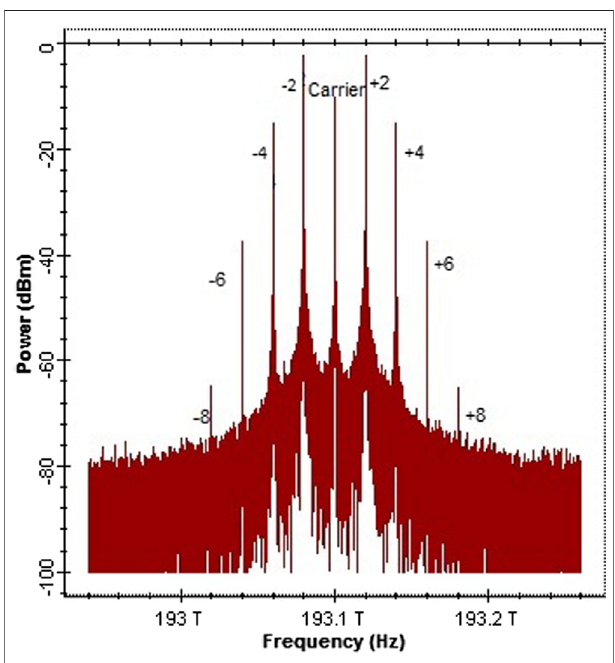
FIGURE 2 | Optical spectrum output from MZM-A containing only even order